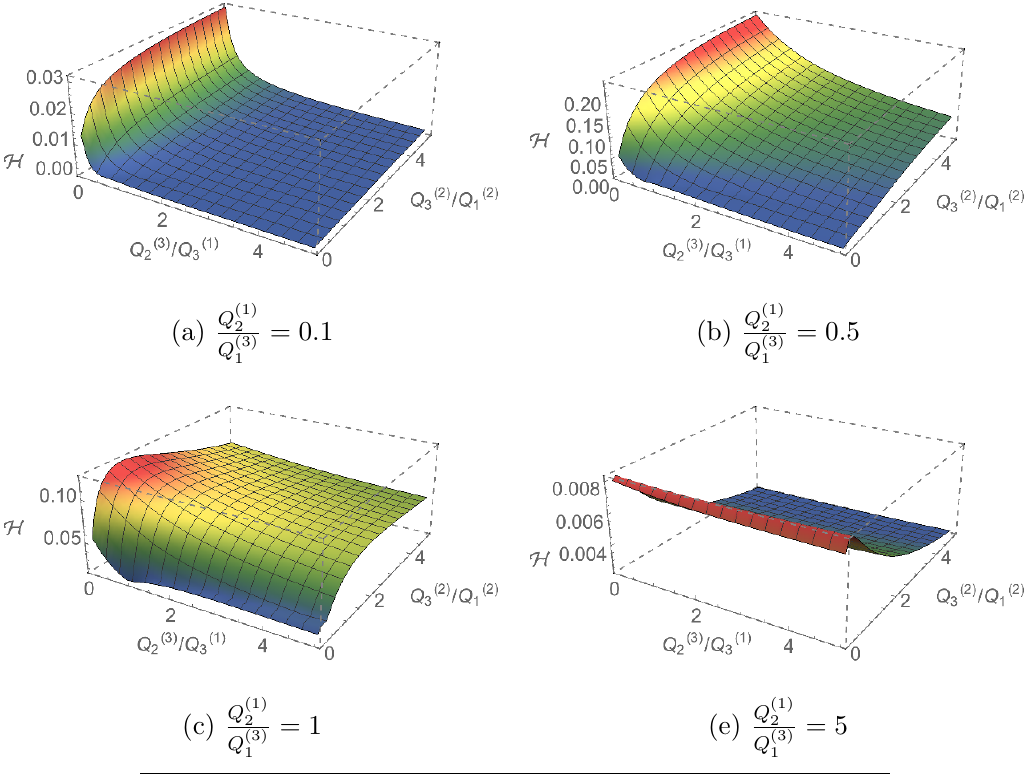
Figure 6 . The entropy parameter H as a function of the charge ratios with q 0 , q 2 , k 1 , (cid:0) k 2 and k 3 equal to